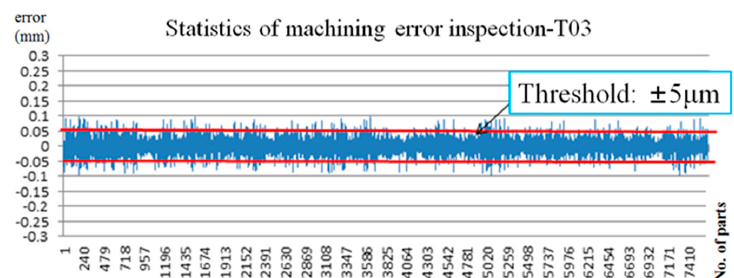
Figure 20. On ‐ machine machining inspection result for T03.